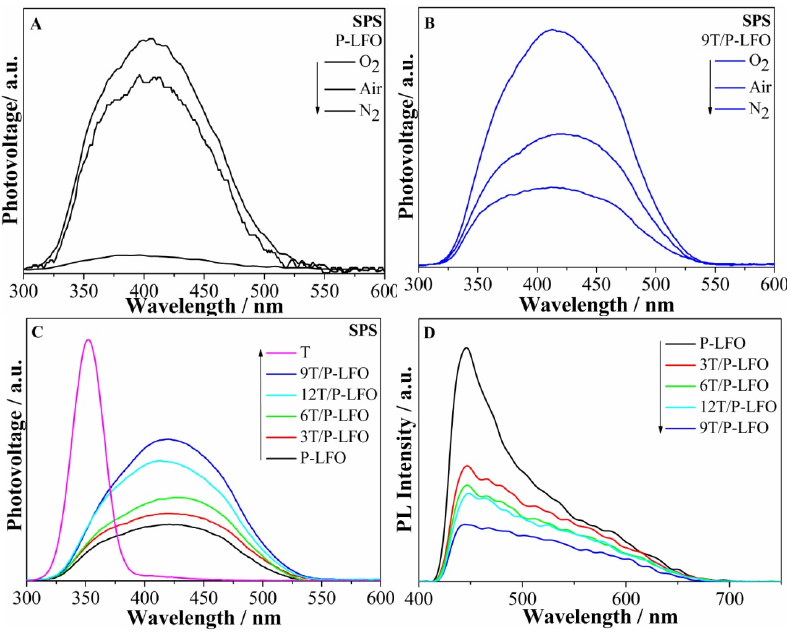
Figure 5. Surface photovoltage spectroscopy (SPS) responses of P-LFO ( A ) and 9T/P-LFO ( B ) in different atmospheres; SPS responses of P-LFO and T/P-LFO nanocomposites in air ( C );